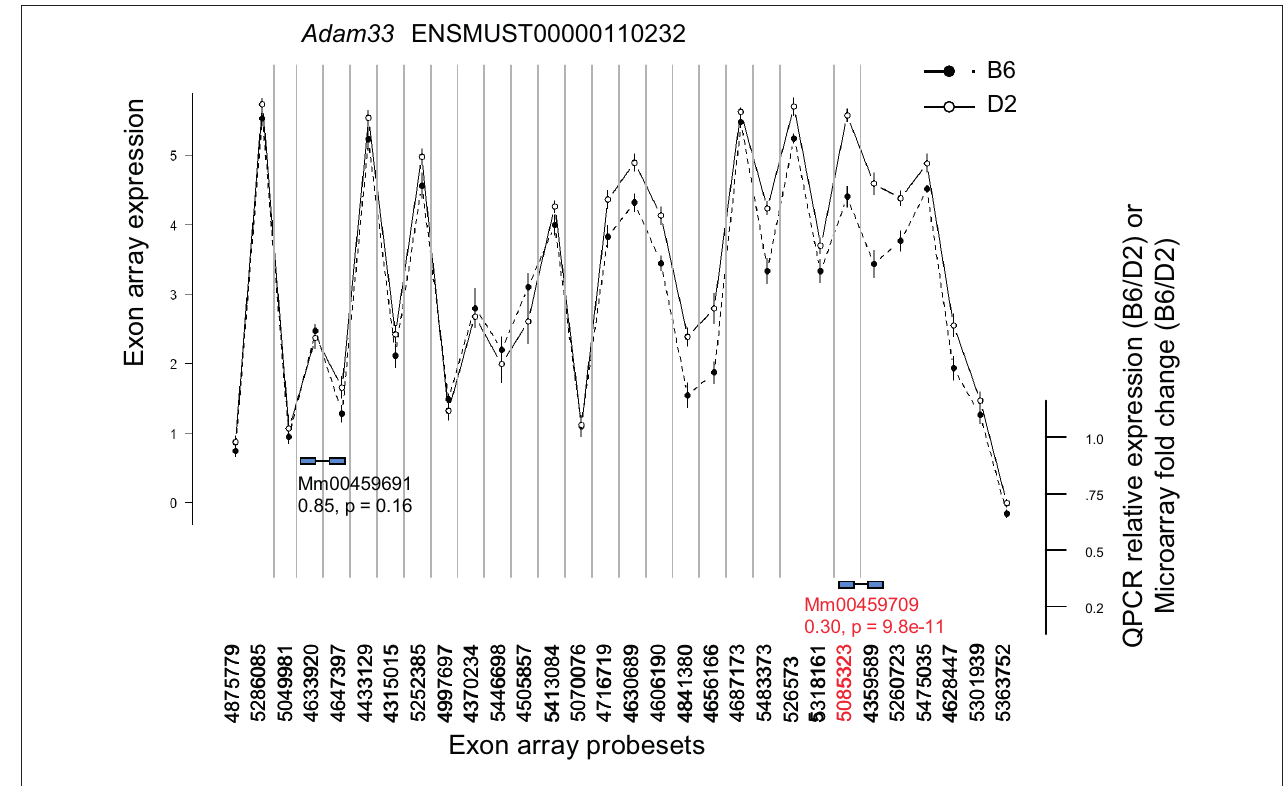
FiguRe A3 | Adam33 , an additional qPCR confirm. Legend is identical as for Figure 6